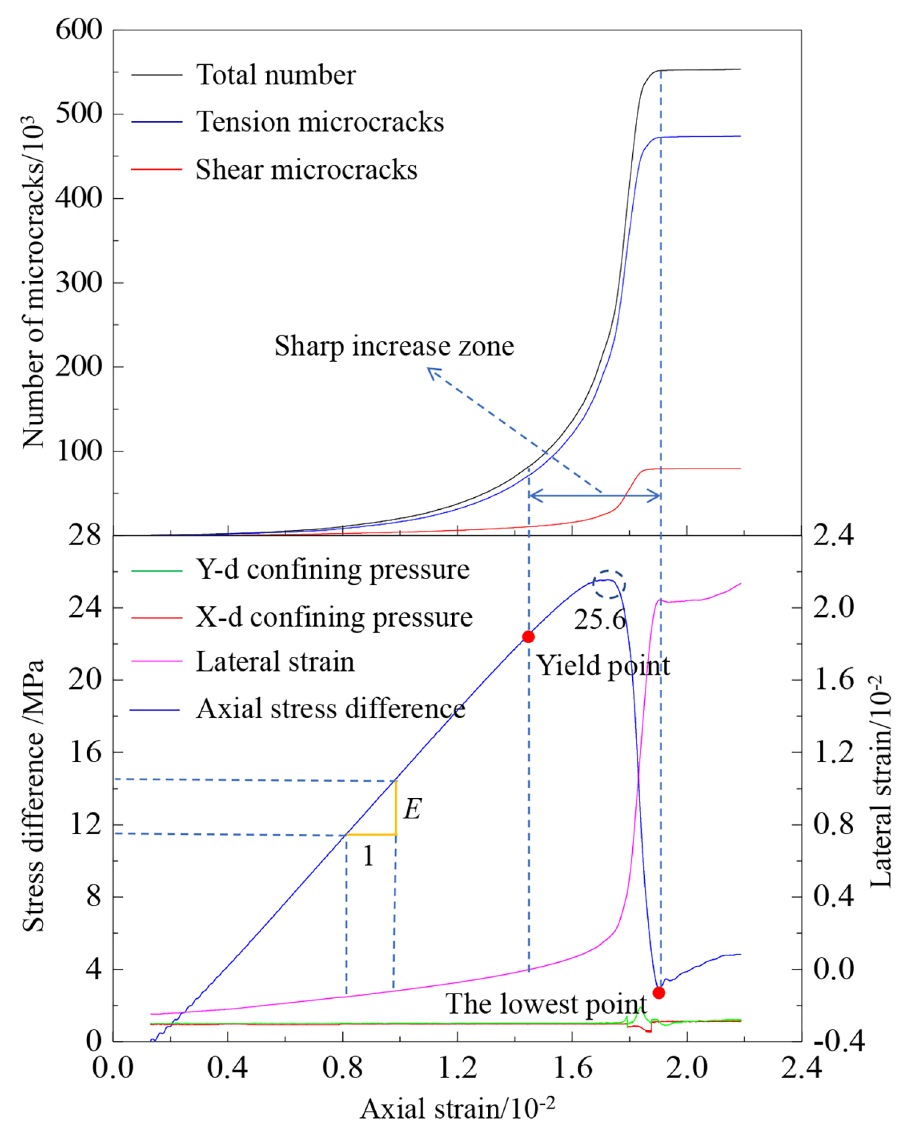
Fig. 8 Numerical results of stress and strain for jointed coal after triaxial compression with loading perpendicular to bedding planes. Y -d and X -d refer to the Y - and X -directions,